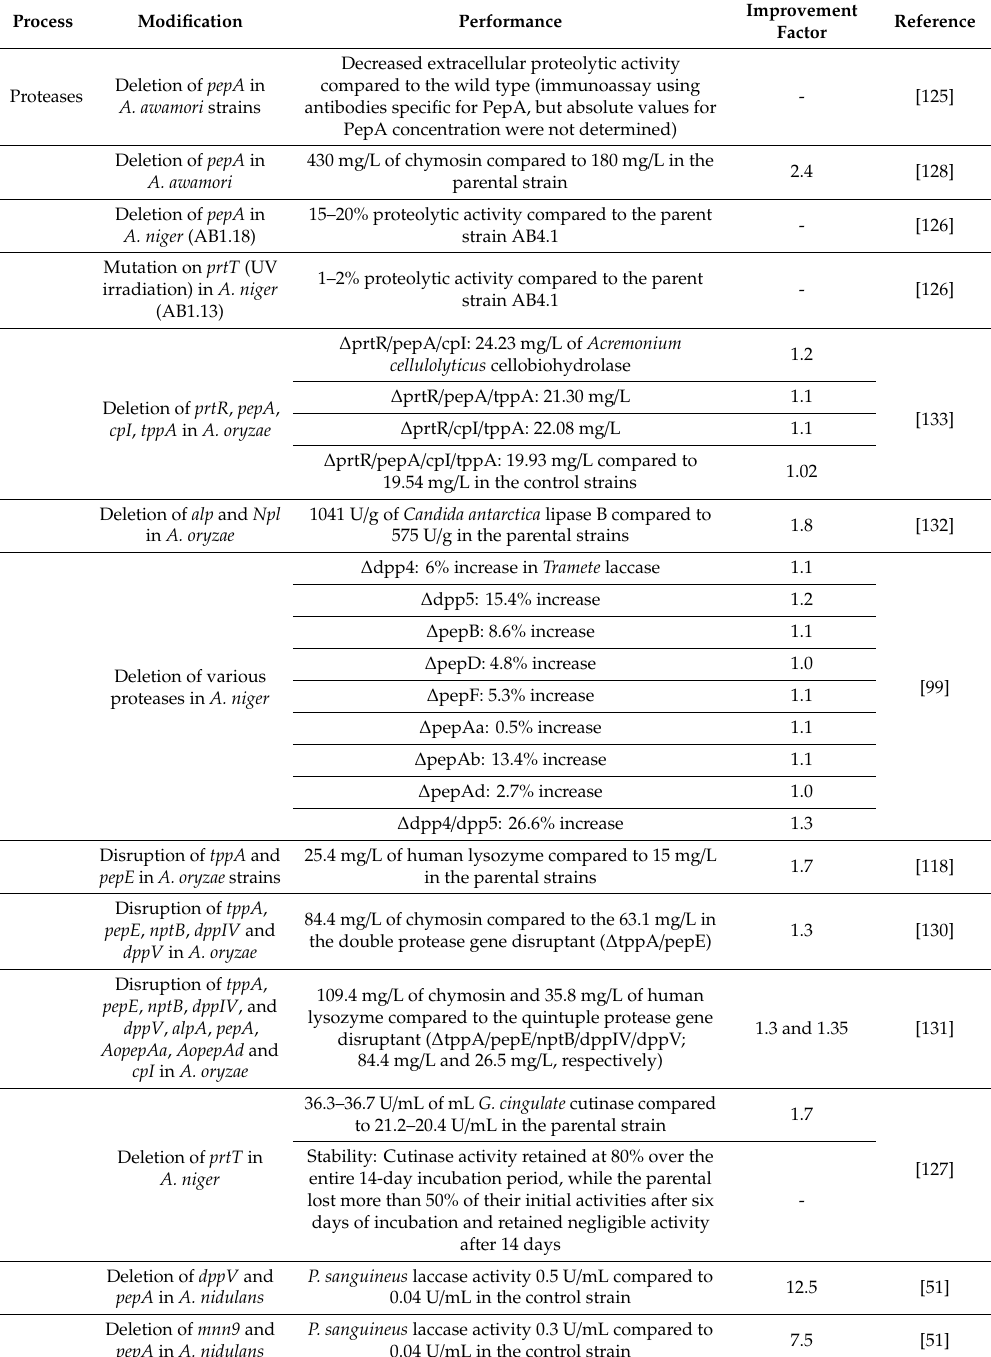
Table 10. Approachesforimprovingrecombinantproteinproductionthroughdisruptionofproteasegenes.